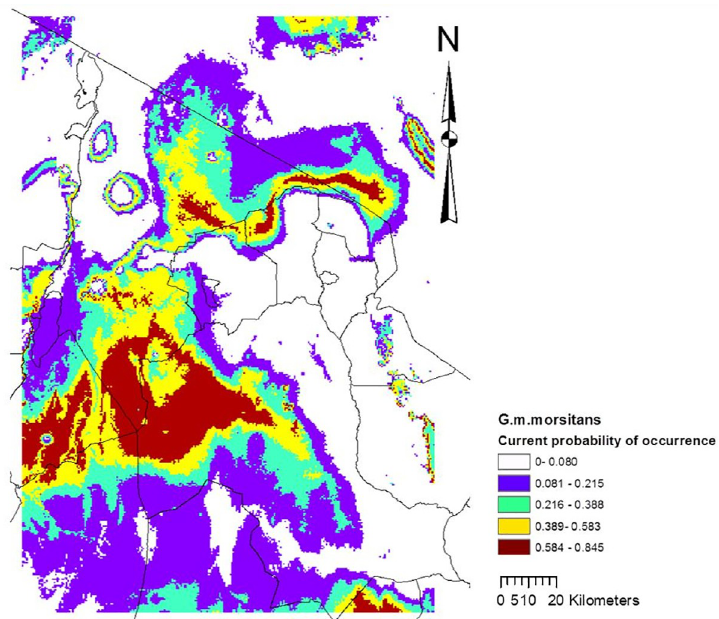
Fig 2. Current climate suitability map for the best performing model with the G . m . morsitans occurrence data, and all 4 environmental variables: elevation, precipitation of the wettest month (April), mean maximum temperature of the warmest month (February), and mean minimum temperature of the coldest month (July).